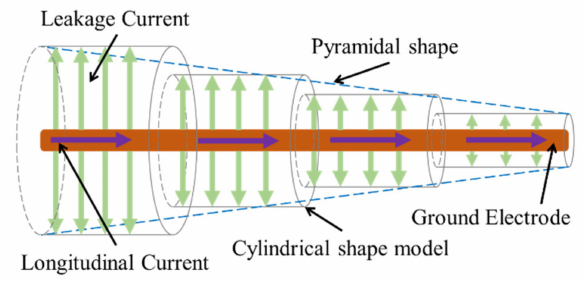
Figure 2. Ionized zone of the soil around the